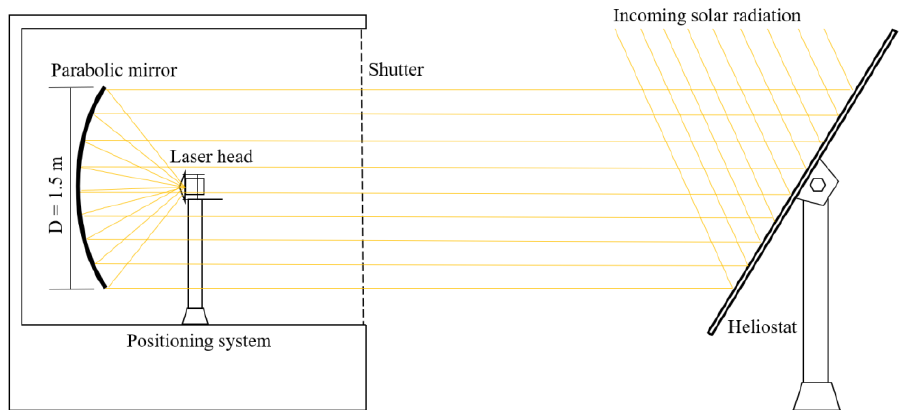
Figure 1. Schematics of the NOVA heliostat-parabolic system for pumping the four-rod Nd:YAG solar laser head.